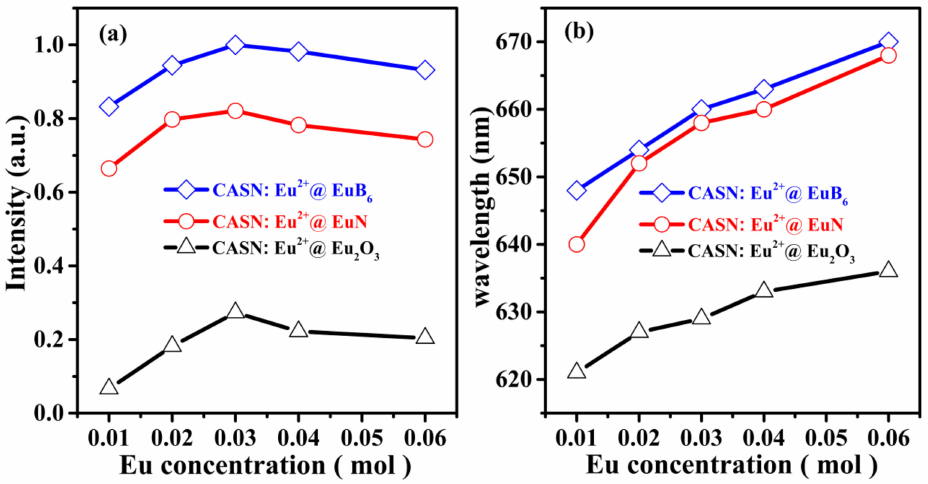
Figure 7. Dependence of emission intensity ( a ) and peak position ( b ) of CASN:Eu 2+ @Eu 2 O 3 (black line), CASN:Eu 2+ @EuN (blue line) and CASN:Eu 2+ @EuB 6 (red line) phosphors with various Eu 2+ concentration ( x = 0.01, 0.02, 0.03, 0.04,